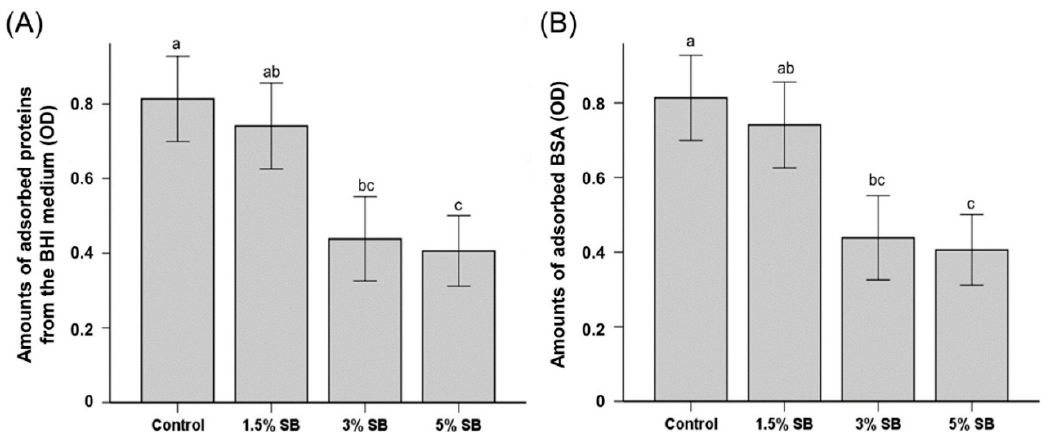
Figure 2. Comparison of the optical density (OD) of the protein adsorbed from a brain heart infusion (BHI) medium ( A ) and adsorbed bovine serum albumin (BSA ( B )) among resin sealants with different concentrations of sulfobetaine methacrylate (SB). The OD is proportional to the amount of adsorbed protein. Different lowercase alphabetical letters above bars indicate significant differences.